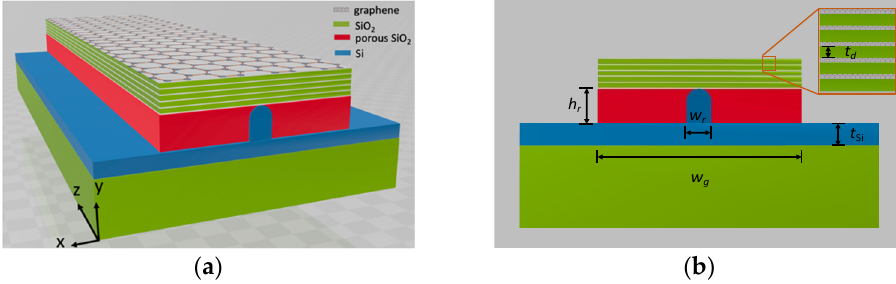
Figure 1. Schematic of the proposed waveguide structure—( a ) 3D structure and ( b ) cross section of ( a ) with a zoomed-in view of the MLGMTs.